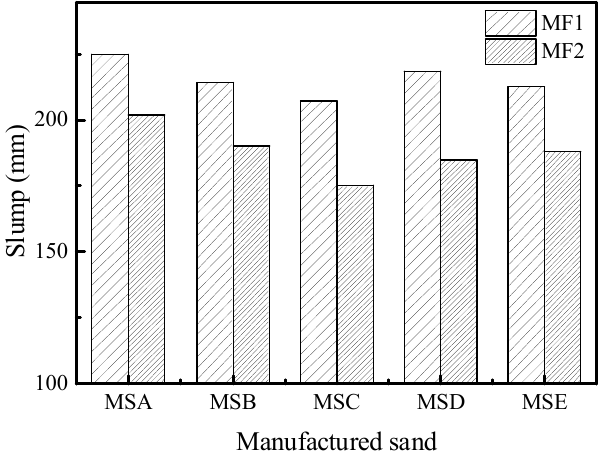
Figure 16. Slump of concrete with different manufactured sands.